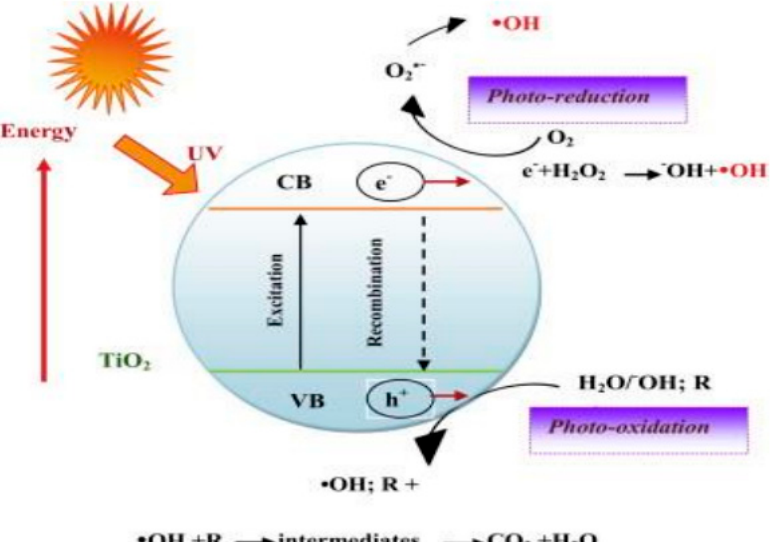
Figure 6. Schematic illustrating of TiO 2 photocatalytic process (Adapted with permission from Jurnal Teknologi) [197].